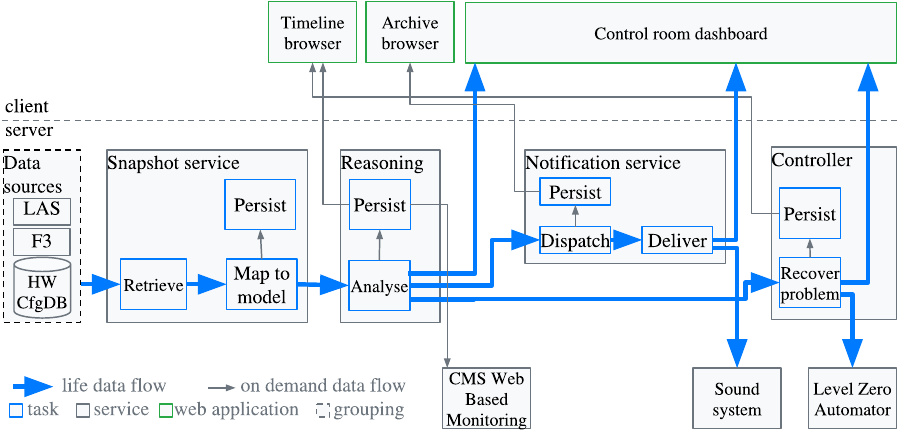
Fig. 1. Main components of the new DAQ-Expert tool. LAS: Live Access Server of the XDAQ Monitoring and Alarming System (XMAS [14]). F3: elastic-search based monitoring of the File- based Filter Farm. HWCfgDB: CMS DAQ Hardware and Configuration Database. The server side consists of four micro-services: Snapshot Service, Reasoning Service, Notification Service,